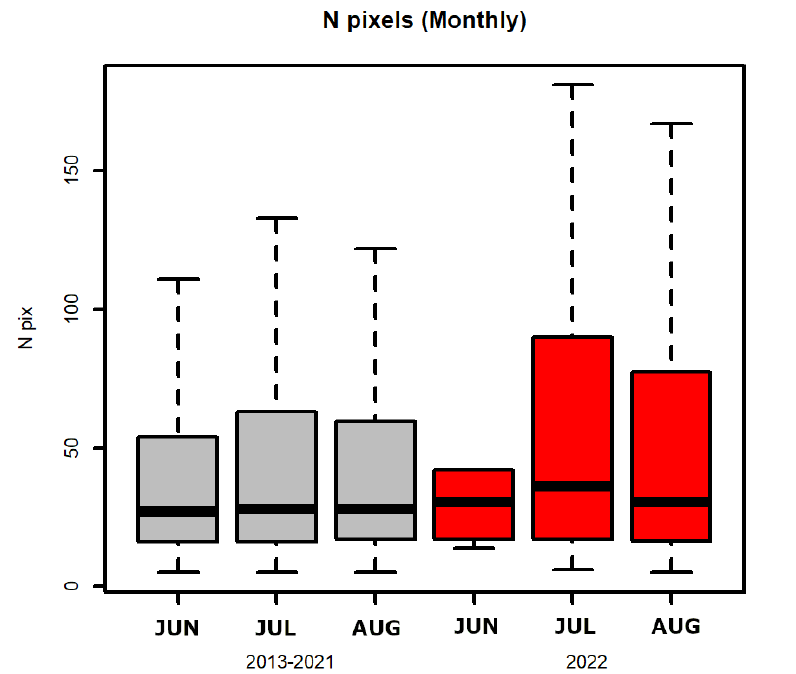
Figure 9. Same as Figure 8, but for the monthly